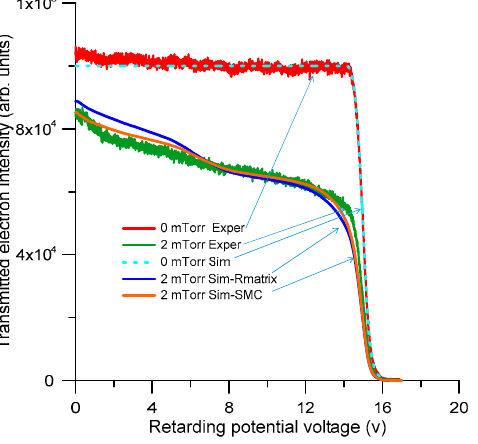
Figure 9. Transmitted electron intensity distribution (i.e., the intensity of the electrons with axial kinetic energy above the retarding potential barrier) through 0 and 2 mTorr of pyridine, respectively, for a 15 eV incident electron energy beam.